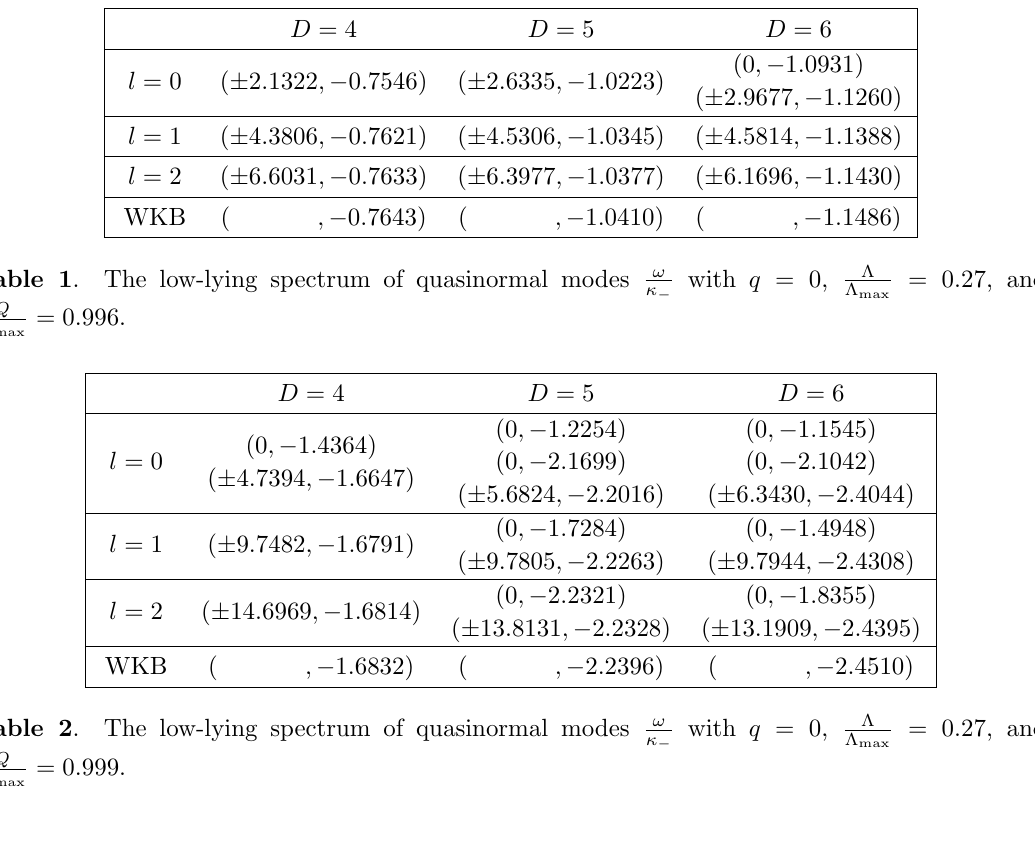
with q = 0, (cid:3) (cid:20) (cid:0)